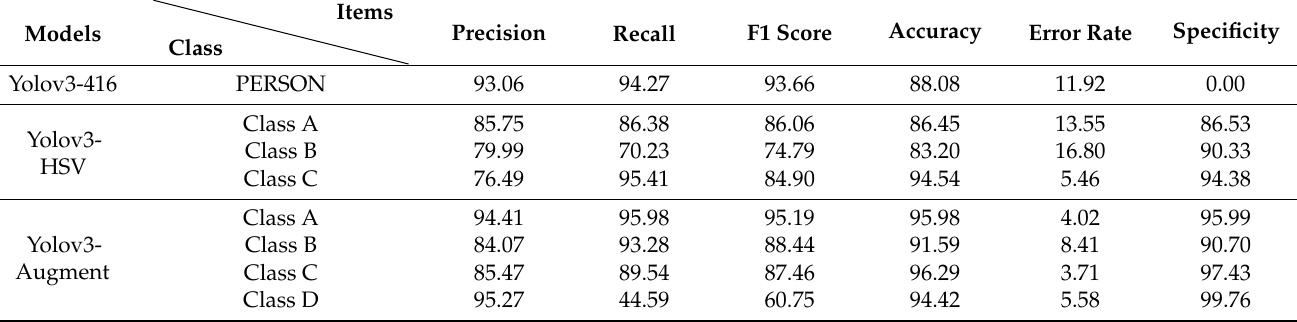
Table 5. Class-specific performance of the AI models (units: